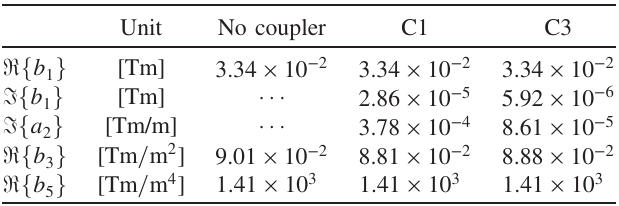
TABLE VII. Multipolar moments with and without fundamen- tal coupler at a total deflecting voltage of 10